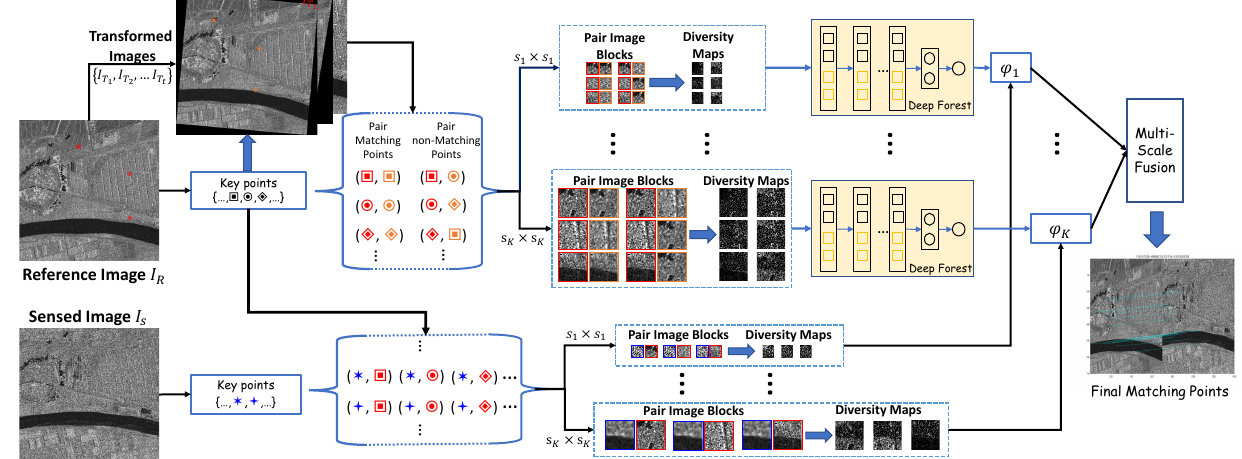
Figure 2. The framework of the proposed